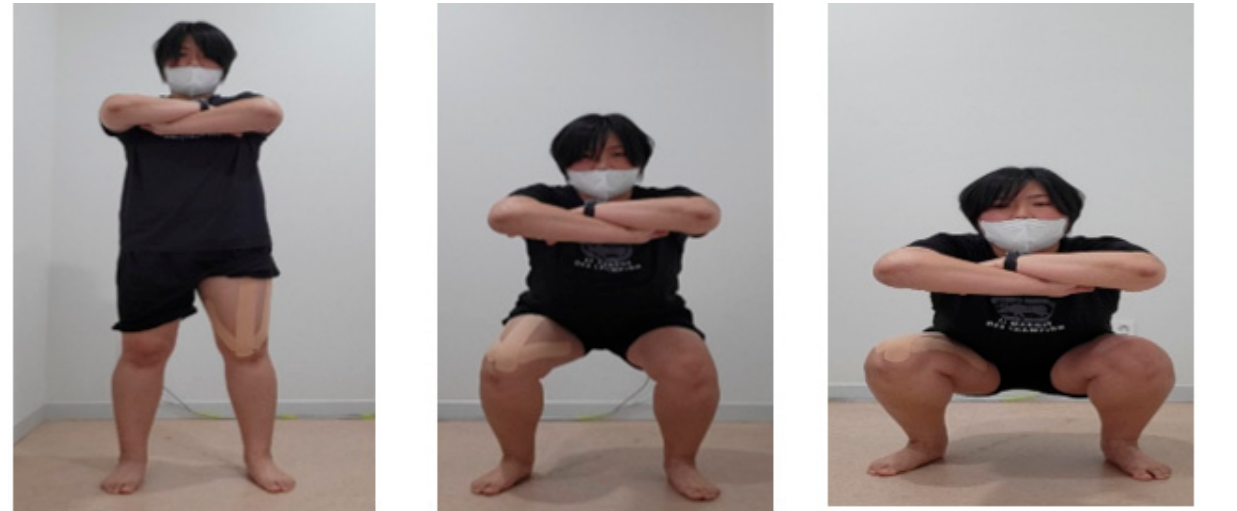
Figure 4. Sham Kinesio taping with squat exercise. 2.5. Measurement Variables 2.5.1. Muscle Activity in the Lower Extremities Muscle activity of the lower extremities was also measured by using EMG Noraxon Mini DTS (Noraxon, Inc., Scottsdale, AZ, USA). The common mode rejection ratio (CMRR) was 100 dB or more, and the input impedance was 100 Mohm or more. EMG signals were collected at a sampling rate of 1500 Hz with the notch filter set at 60 Hz. The EMG signal was obtained from 10 to 500 Hz using MyoResearch-XPME 1.07 (Noraxon, Inc., Scottsdale, AZ, USA) software. The first order high-pass and fourth order low-pass were filtered us- ing Butterworth filters. The collected data were converted into root mean square values for analysis. To analyze the isometric contraction phase—which occurred during the 5 s- long pause following the execution of motion—only the data from the middle 3 s were used, with the exclusion of the initial and final second. To reduce the skin impedance of subjects, alcohol prep pads were applied on the point of attachment of the electrodes be- fore evaluation. The point of attachment of the electrodes for the vastus medialis muscle was 4 cm above the medial surface of the patella, 3 cm on the medial side, 55° from the long axis of the patella, and the vastus lateralis muscle was 10–15 cm above the top surface of the patella, with a position of 15° from the long axis of the patella at a height of 6–8 cm. The flat-legged root was attached two-thirds of the way along the straight line between the knee bone and the lower front part [17]. The measurement posture measured three full squats and three half squats in the same posture as the squat exercise.